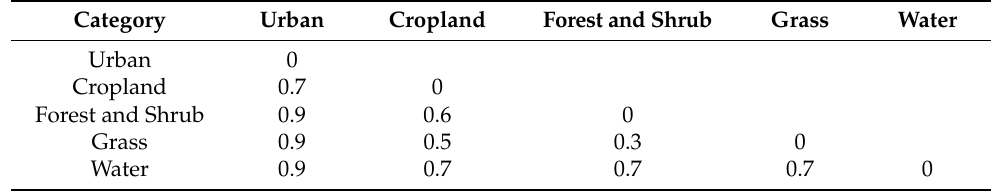
Table 11. Edge contrast values for LULC